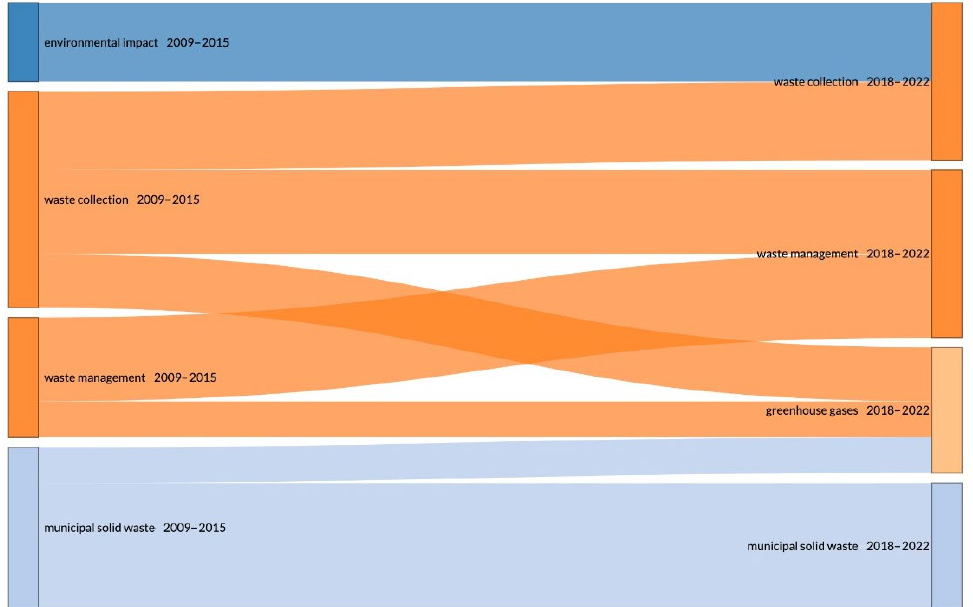
Figure 7. Thematic map during the period 2009–2022 using R-studio software and bibliometrix library.